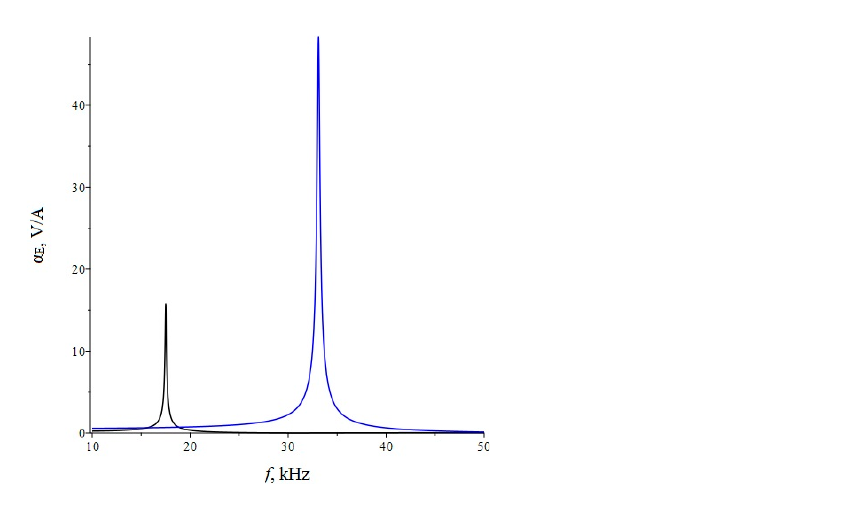
Figure 6. Theoretical dependence of the ME voltage coefficient on the frequency of the alternating magnetic field. Black color of the line is PZT, blue is LN cut y + 128°. Cantilever Clamping of ME Composite.